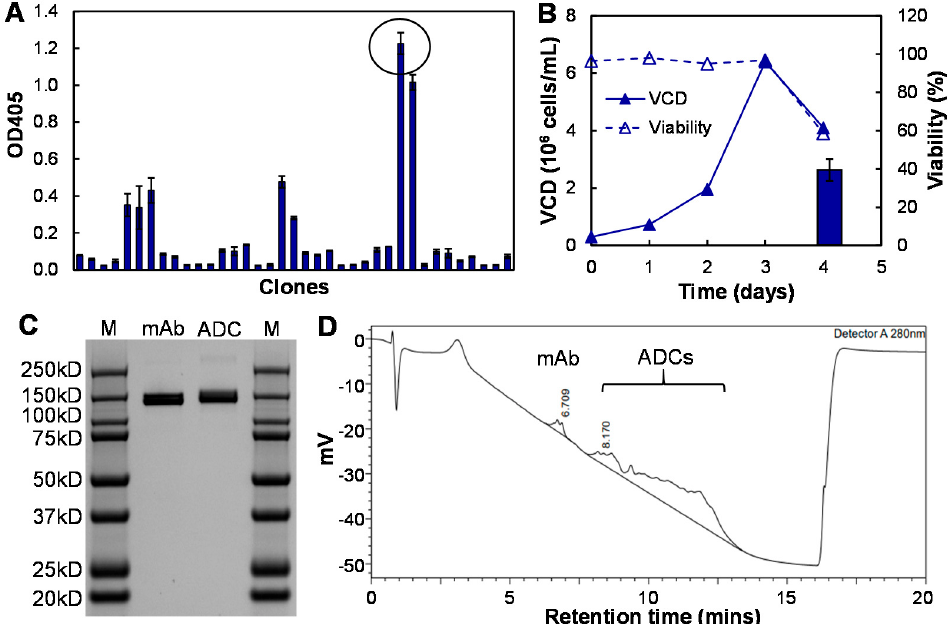
Figure 2. Anti-CD47 mAb and ADC development. ( A ) Rank of top anti-CD47 mAb clones based on the antibody titration using ELISA screening (data represent mean ± SEM, n = 3). ( B ) The anti-CD47 mAb production and hybridoma cell growth in shaker flask cell culture (data represent mean ± SEM, n = 3). Viable cell density (VCD): ▲ , cell viability: Δ . ( C ) SDS-PAGE to confirm the integrity and purity of mAb and ADC. ( D ) Analysis of ADC synthesis efficiency (i.e., antibody–drug conjugation rate) using HPLC equipped with a MAbPac HIC-Butyl column.